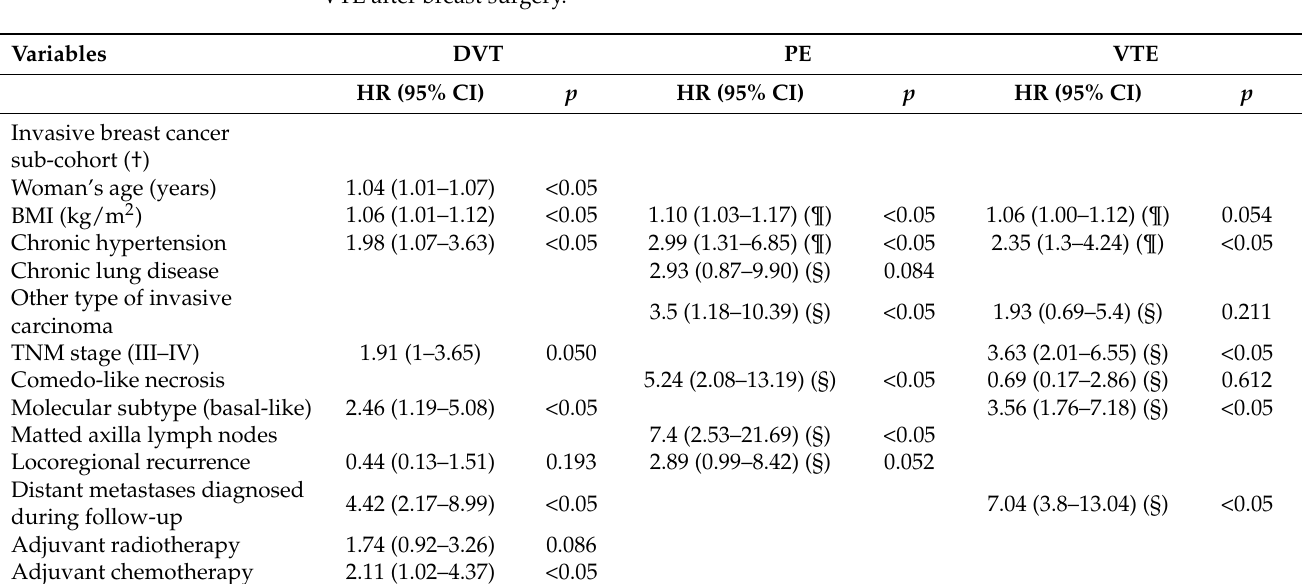
Table 6. The table shows the factors associated with a new diagnosis of deep vein thrombosis (DVT), the table shows the sub-cohort of invasive breast cancer analysis. The reported values refer to multivariate Cox proportional hazards model analysis considering the new diagnosis of DVT, PE, or VTE after breast surgery.